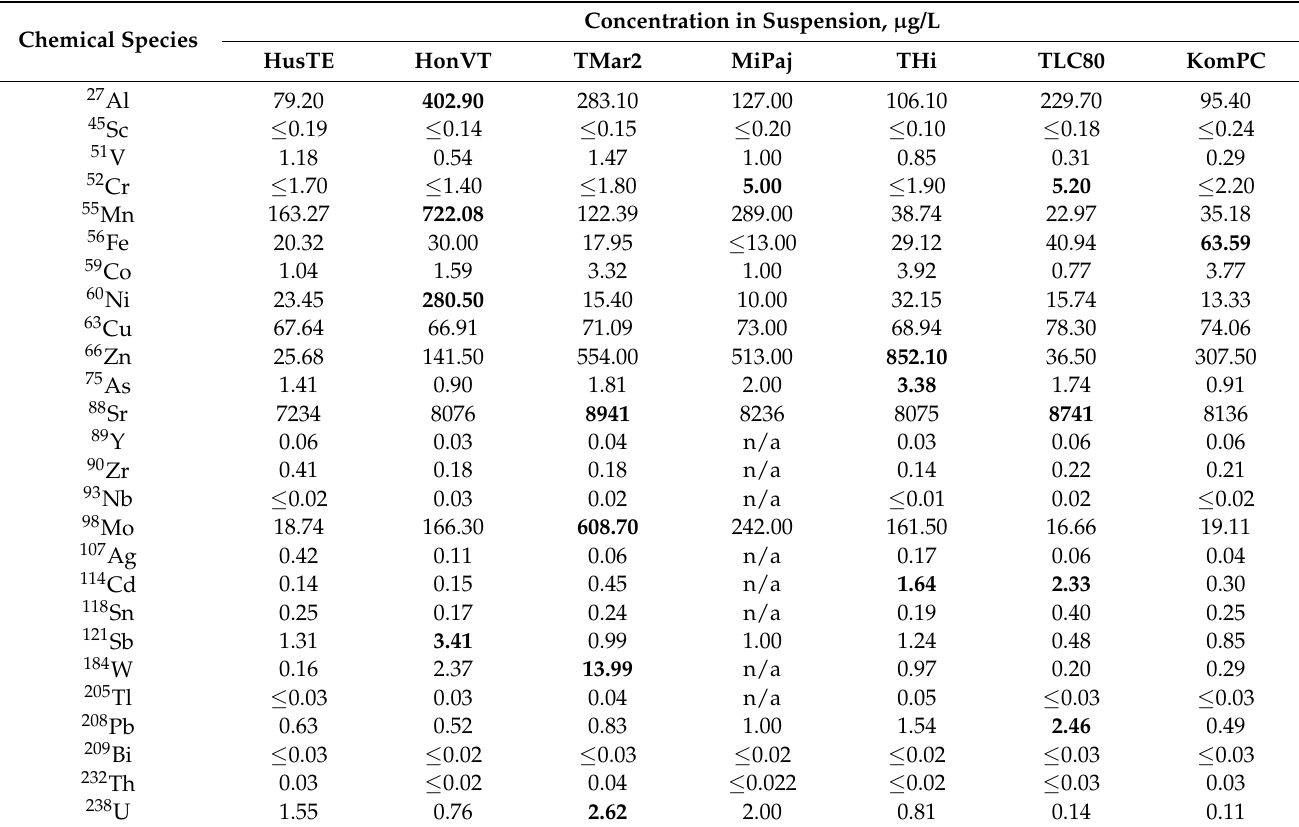
Table 4. The results of ICP-MS analyses of VEP suspensions in seawater.